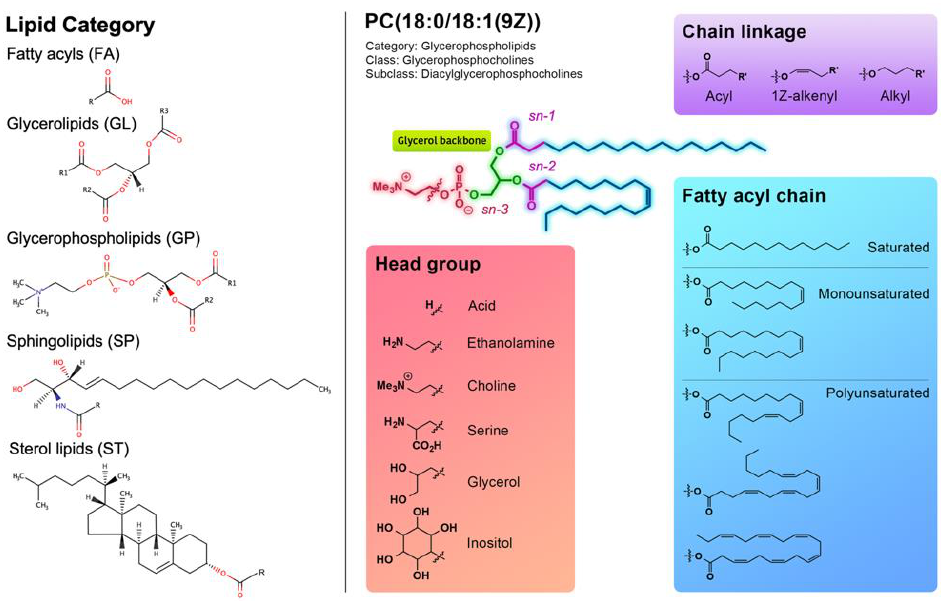
Figure 1. Common structural features of lipid molecules. Lipid categorization, classification, and structural features according to LIPID MAPS consortium [22]. Five lipid categories clinically relevant to CRC are shown: FA, fatty acyls; GL, glycerolipids; GP, glycerophospholipids; SP, sphingolipids; ST, sterols. Structural features include functional head groups, fatty acyl chain types, and chain linkage diversity.